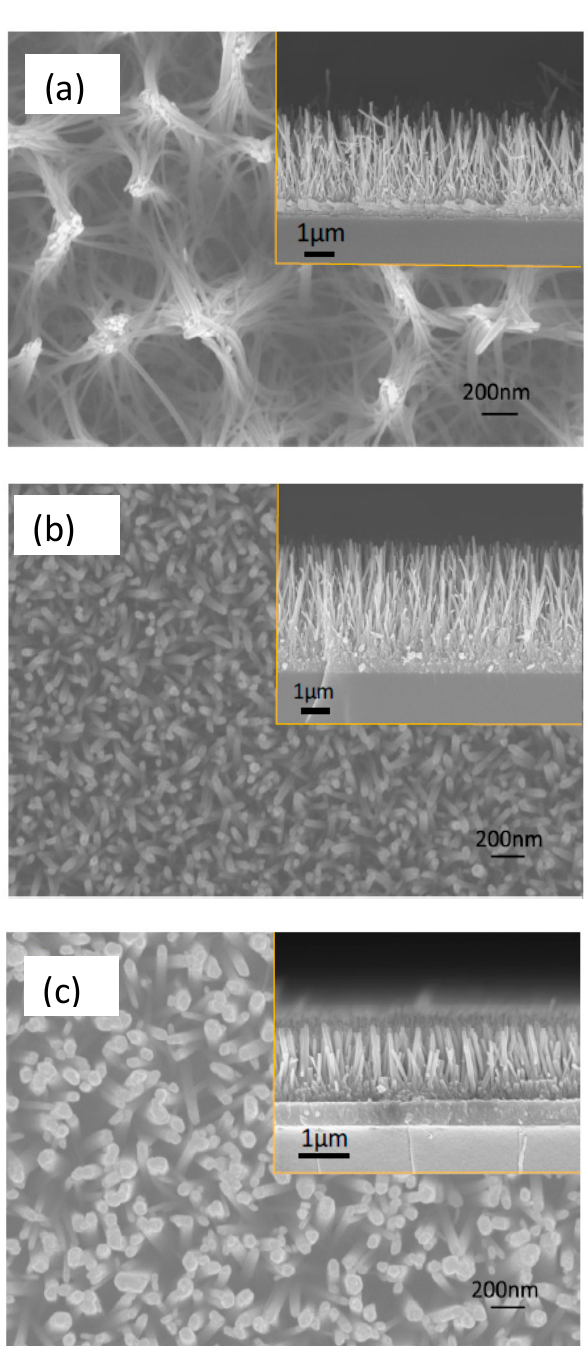
Figure 8. FE-SEM images of ZnO NW arrays used to optimize the dye loading conditions. NWs in ( a – c ) have average diameter 20–25, 30–40 and 80–100 nm, respectively.